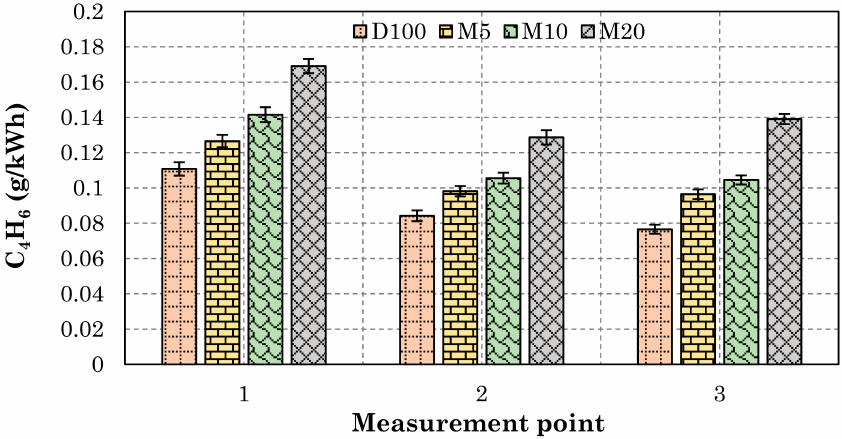
Figure 15. Specific butadiene emissions for all test fuels at all measurement points (error bars represent the standard